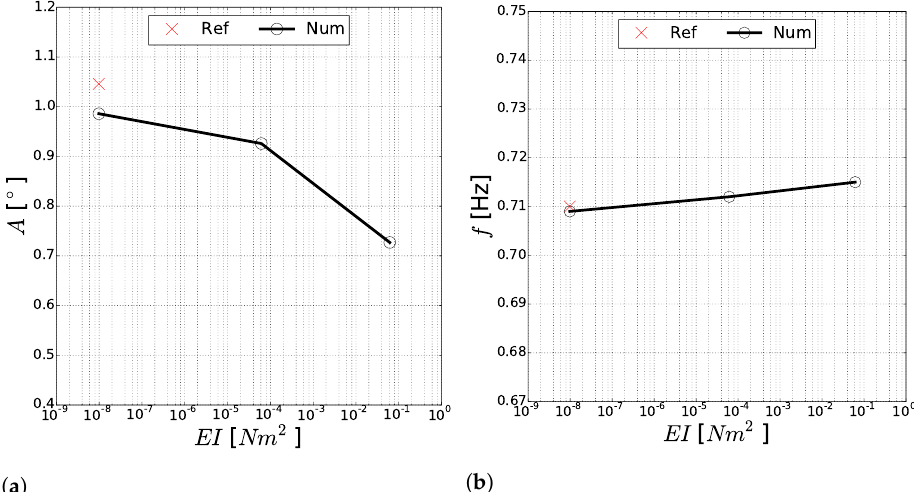
Figure 23. Parameter study of the effects of EI on the ( a ) amplitude and ( b ) frequency of the pitch